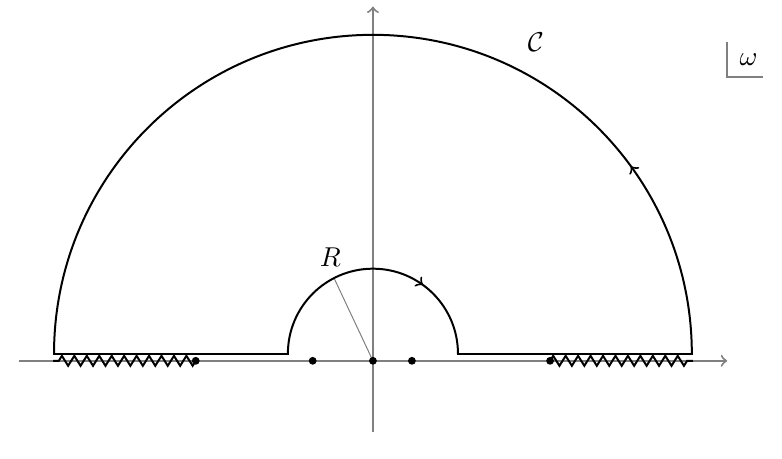
Figure 4 . The contour C that is used in eq.